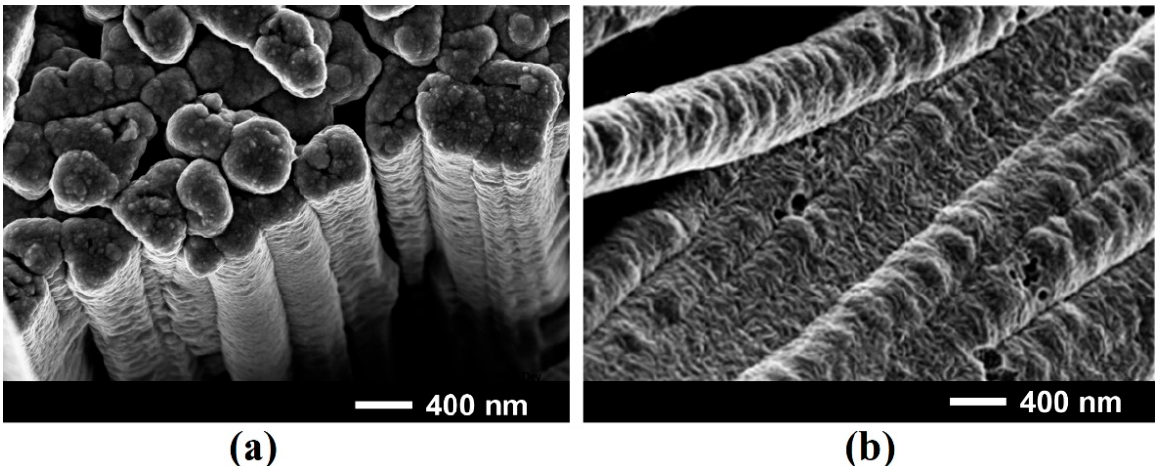
Figure 3. SEM images of Ni 0.65 Fe 0.35 ( a ) and permalloy ( b ) coatings on GaAs nanowires after deposition for 60